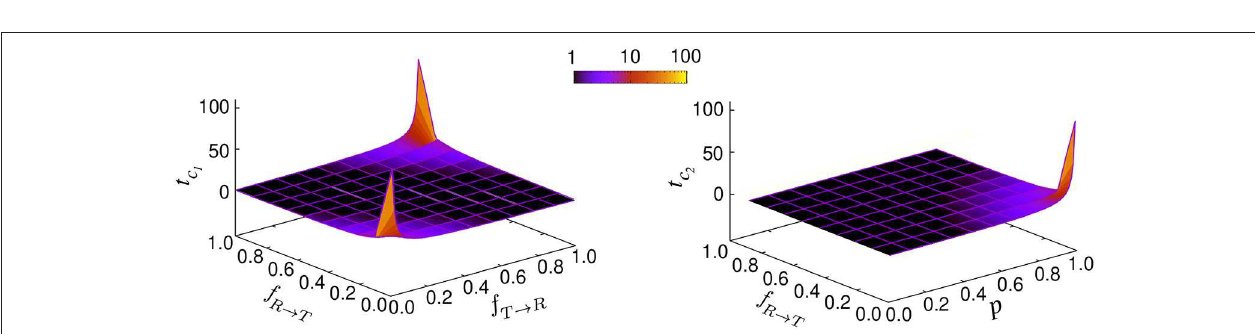
and f and run persistency p . R → T T → R